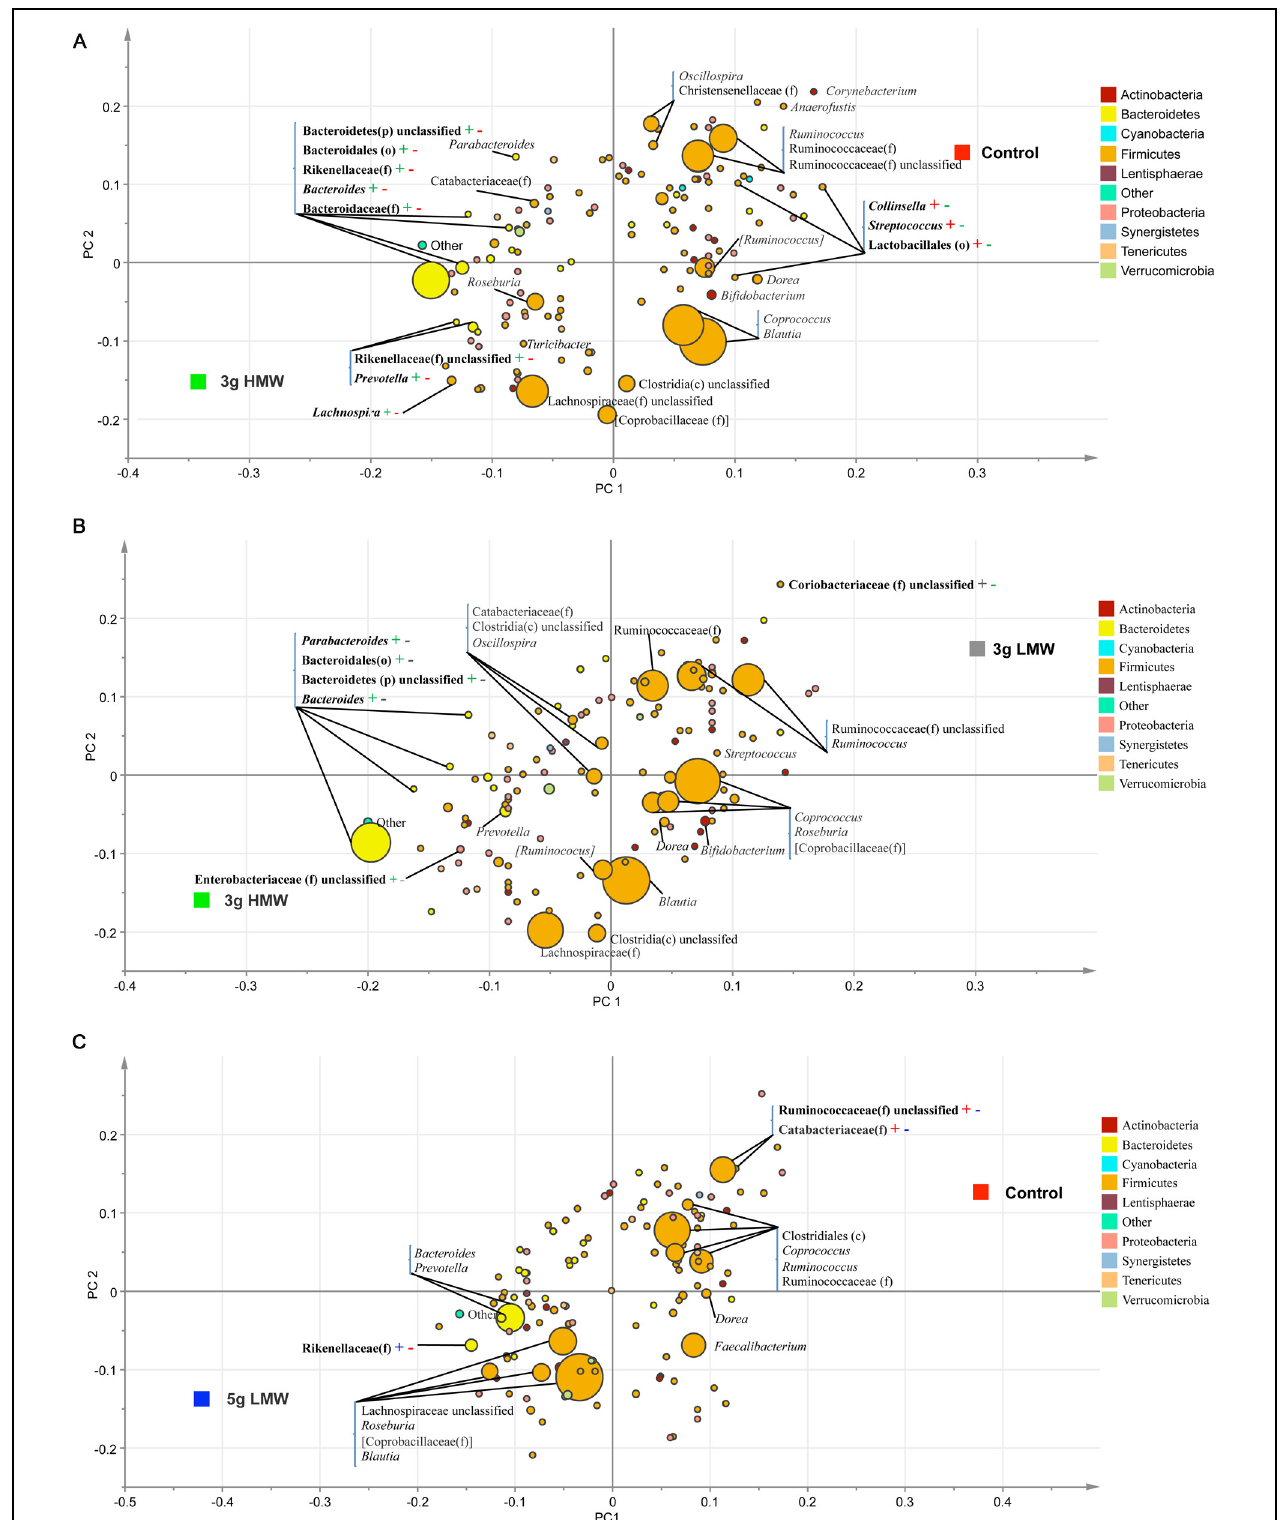
FIGURE 2 | Partial least square discriminant analysis (PLS-DA) loading plot. The PLS-DA graphs were generated based on the relative abundance of the putative bacterial genera in stool samples and their association with (A) 3 g HMW or control diet, (B) 3 g HMW or 3 g LMW diet, and (C) 5 g LMW or control diet. – or + signs and their color are indicative of significant negative or positive associations between each taxa and the associated treatment.